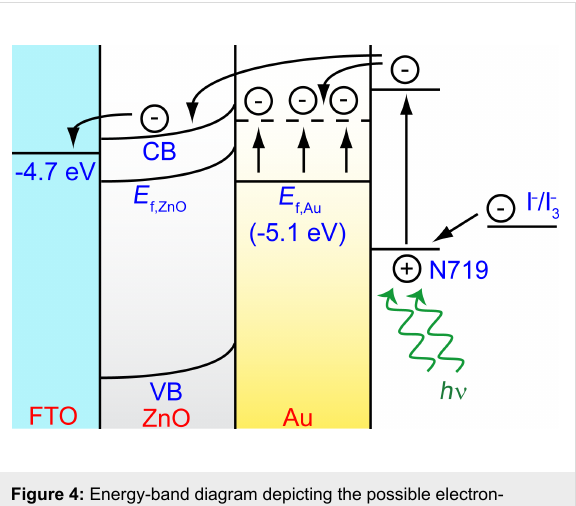
Figure 4: Energy-band diagram depicting the possible electron- transfer path in the ZnO/Au-nanocomposite DSSC, showing the Schottky barrier formed at the ZnO/Au interface. The dashed line in Au represents the position of the Fermi level of gold after electron injec- tion from dye